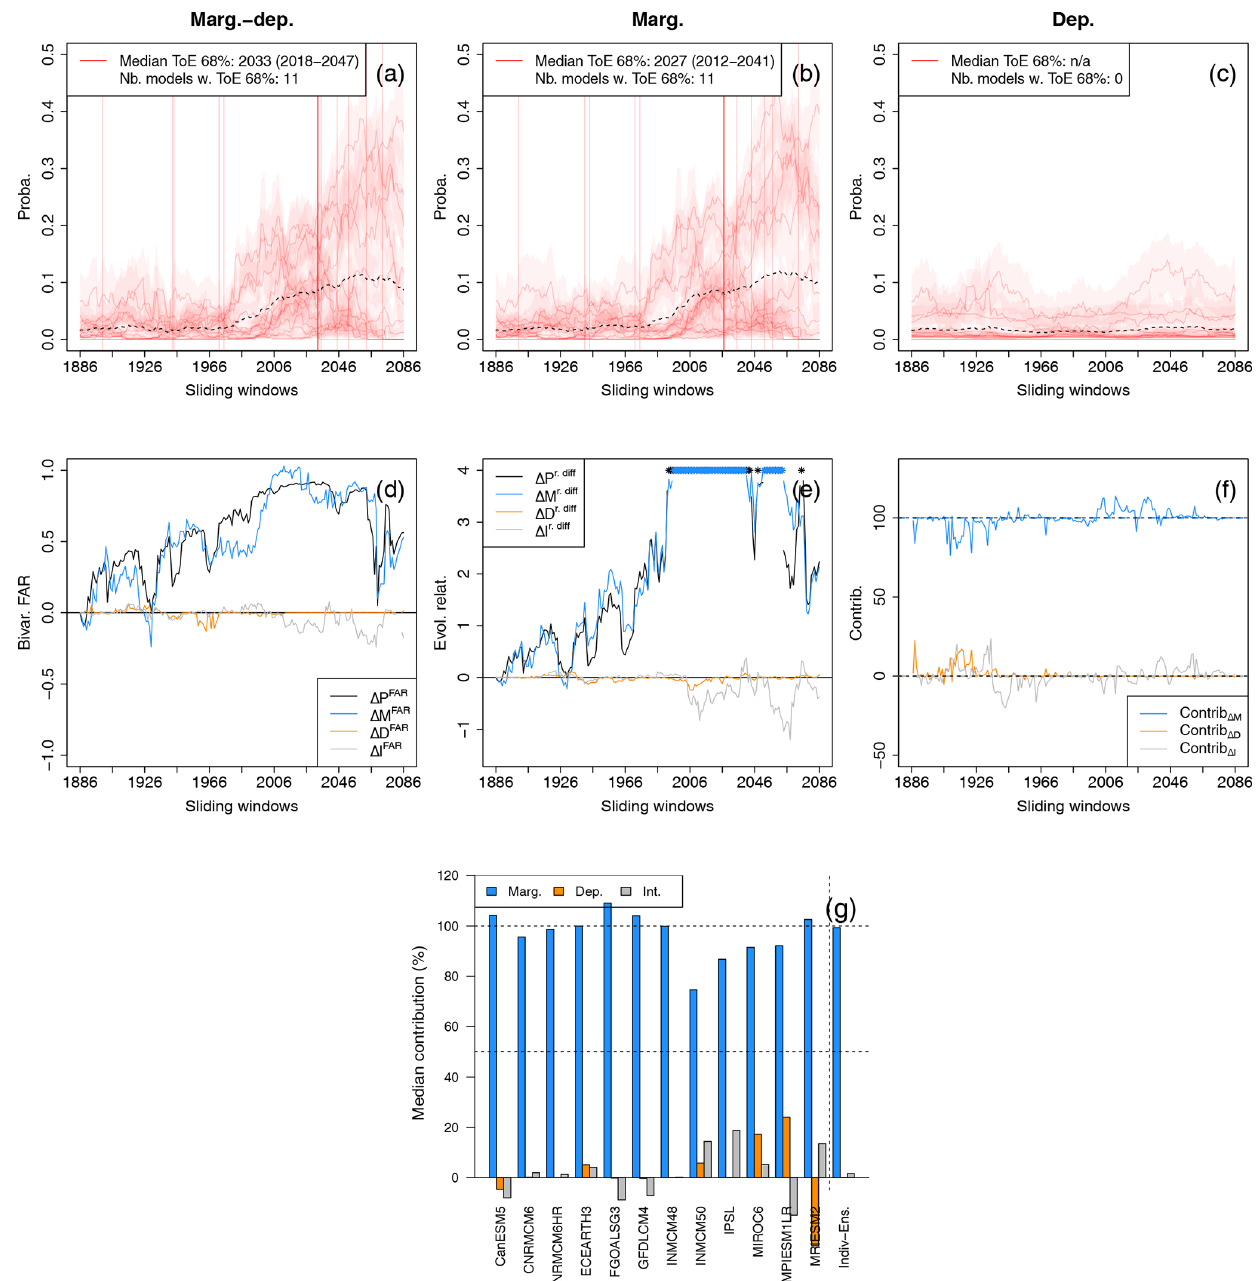
Figure 9. Same as Fig. 7 but for growing-period frost events (GDD ≥ 200 ◦ C.day and minimal temperatures ≤ 0 ◦ C). For (a–c) , not applicable (n/a) is indicated when no time of emergence is